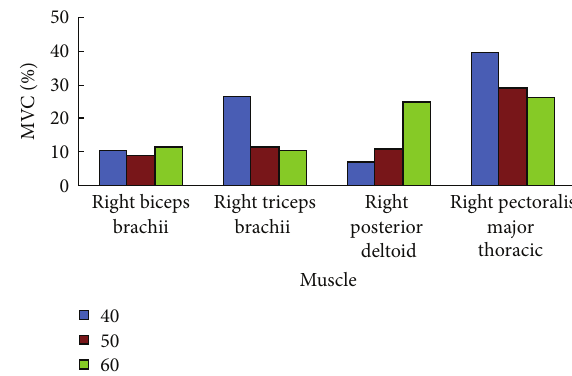
Figure 4: Muscle size and short grip force differences.